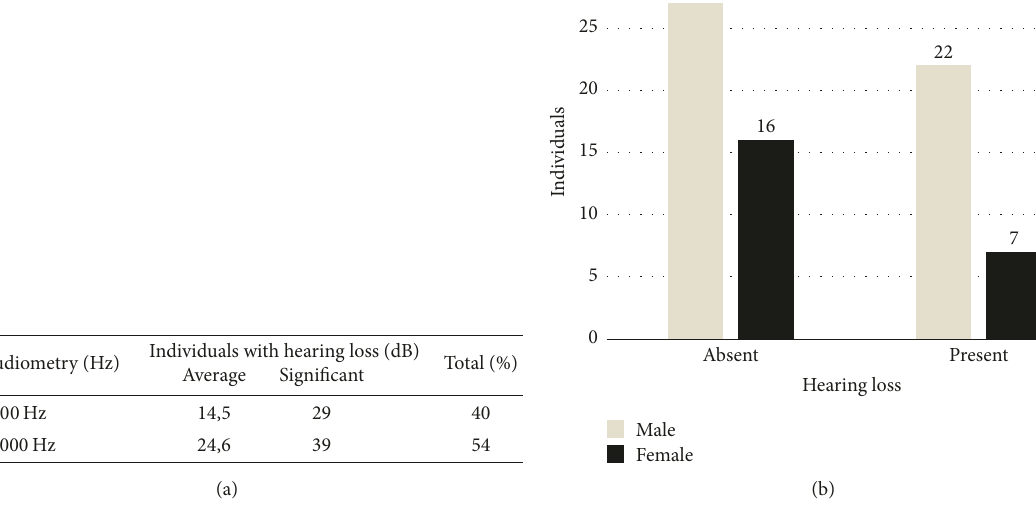
Figure 1: Audiometric studies of cancer patients . Hearing loss for cancer patients was analyzed by a pure-tone audiometry. The average decibel values were obtained for the following range of frequencies, 125–8000 Hz (125, 250, 500, 1000, 2000, 4000, and 8000), and were taken before and after treatment visit (a). The airway was taken as a reference for calculating the loss as long as there was no more than 5 dB gap between airwayandboneconduction.Hearinglosswasconsideredfromadecreaseinaveragegreaterthan10 dBandthenwasplottedontothediagram as a male/female distribution (b).